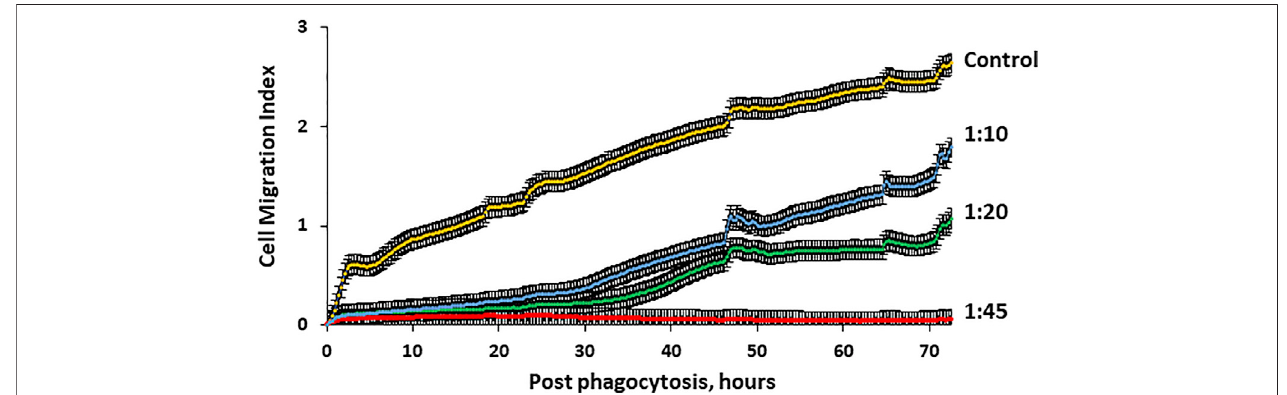
FIGURE 7 | Migration activity ofhMSCs through 8 µm pores is microcapsule loading – dependent. Human MSC migration through micropores was monitored with special16-wellCIMplatesofthexCELLigenceRTCADPsystemasdescribedintheMethods.Thesystemallowsreal-timedeterminationoftheimpedancedynamicsat cell contact withgoldelectrodesand determination ofthe cellindexcorrelatingwiththenumber andareaofcellsattached totheelectrode. Cells (40,000)wereplacedin the upper chamber and allowed to migrate through 8 µm pores to the lower chamber which is 80% covered with gold electrodes. Four wells were used for each experimental group. Signals for the determination of the migration index were registered every 15 min for 72 h. These data demonstrate that cell migration activity through 8 µm pores was microcapsule loading – dependent and signi fi cantly reduced with higher microcapsule loading. p < .01 for cell/microcapsule ratios 1:10, 1:20, and 1:45 when compared with control according to the Wilcoxon